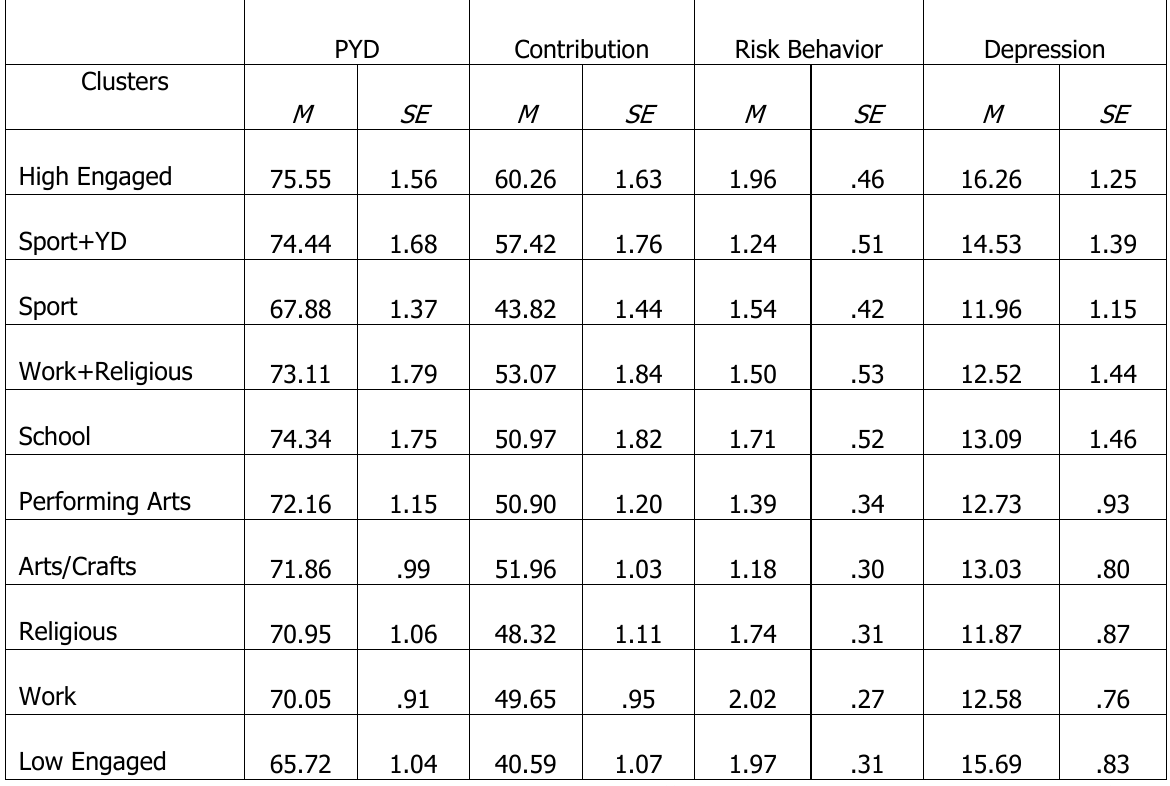
PYD Contribution Risk Behavior